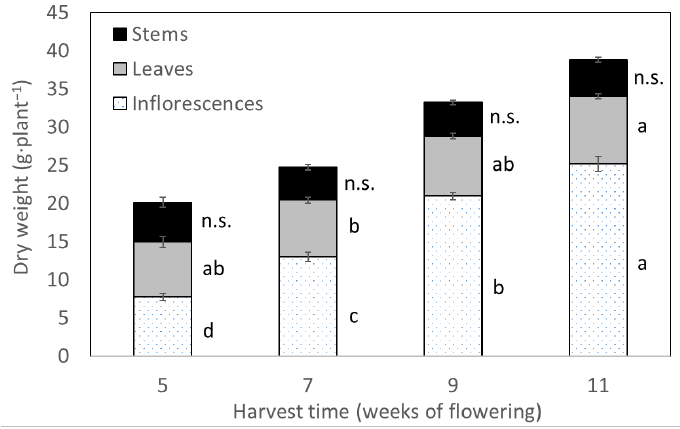
Figure 2. Least square means ( ± standard error) of dry weights (g · plant − 1 ) of stems, leaves and inflorescences for each of the four harvest times (weeks of flowering). For each plant organ, means with at least one identical letter are not significantly different from each other according to Fisher ´ s LSD test with α = 0.05. Values for stems are not significantly (n.s.) different from each other according to global F-test.